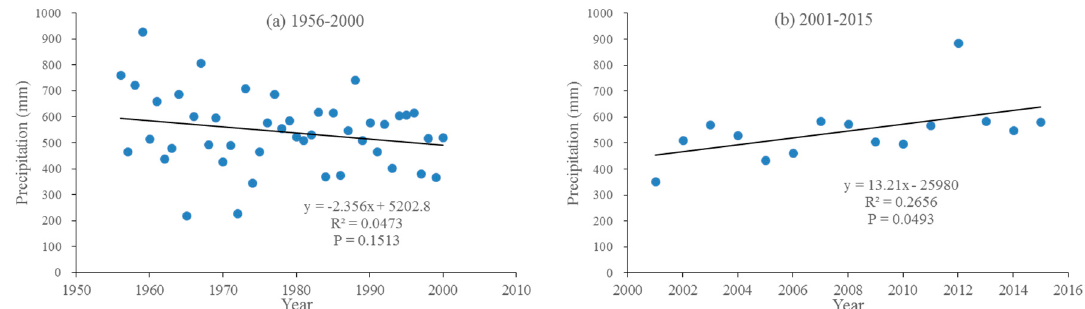
Figure 7. P trend magnitudes for ( a ) 1956–2000 and ( b ) 2001–2015 in the HTRB ( R 2 denotes the correlation coefficients for the relationships, and P denotes the statistical significance).